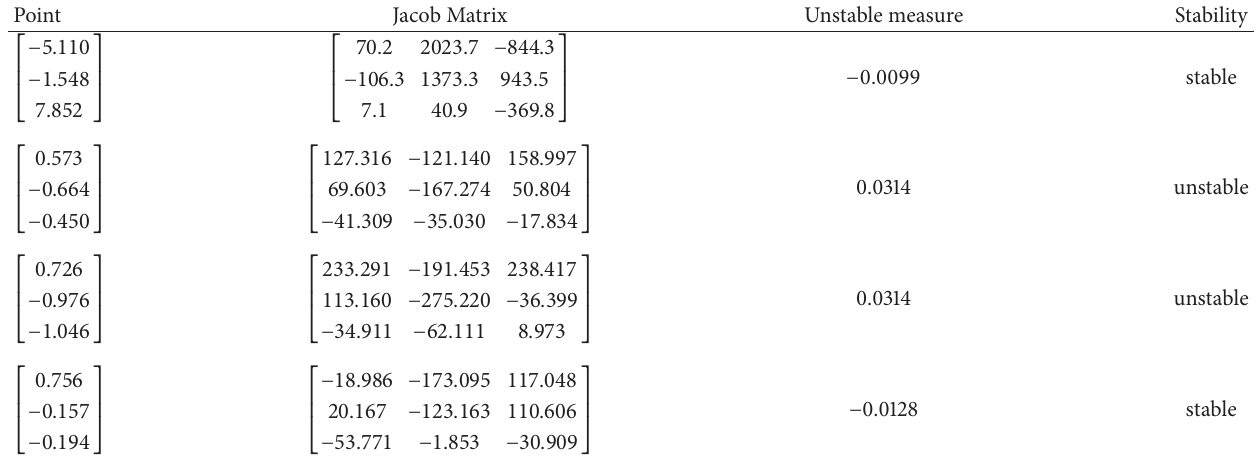
Table 2: Results about stability analysis of economic system about US.